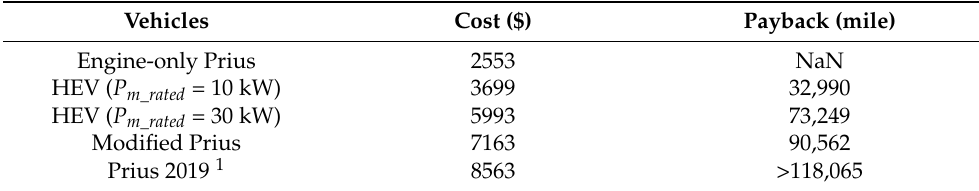
Table 9. Costs of power plants and cost payback mileages for Prius-based vehicles.